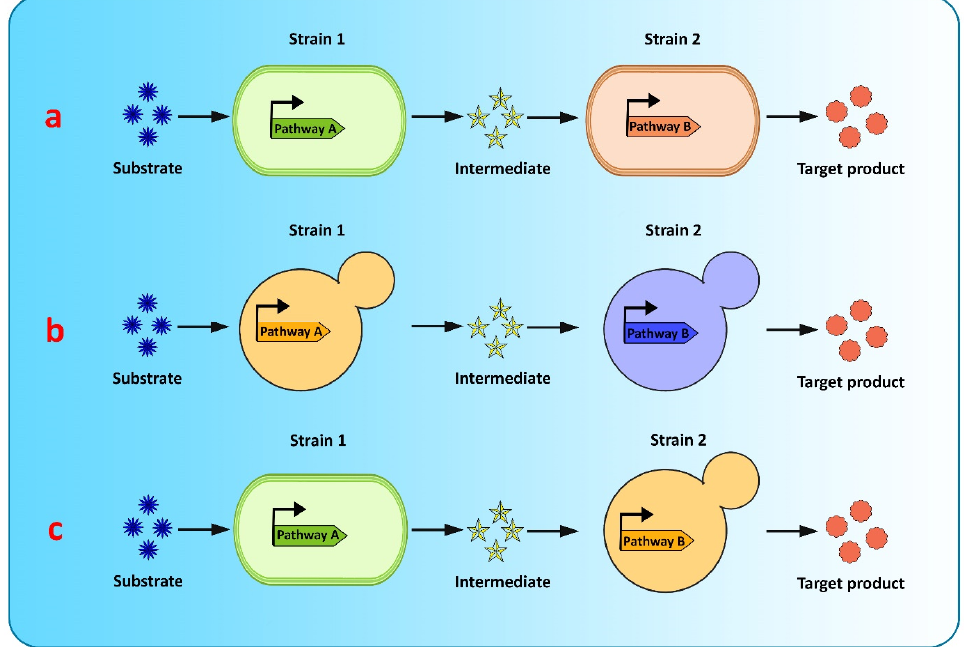
Figure 4. Graphical representation of modular co-culture approach for de novo biosynthesis of flavonoids ( a ) E. coli – E. coli co-culture ( b ) S. cerevisiae – S. cerevisiae co-culture ( c ) E. coli – S. cerevisiae co-culture.